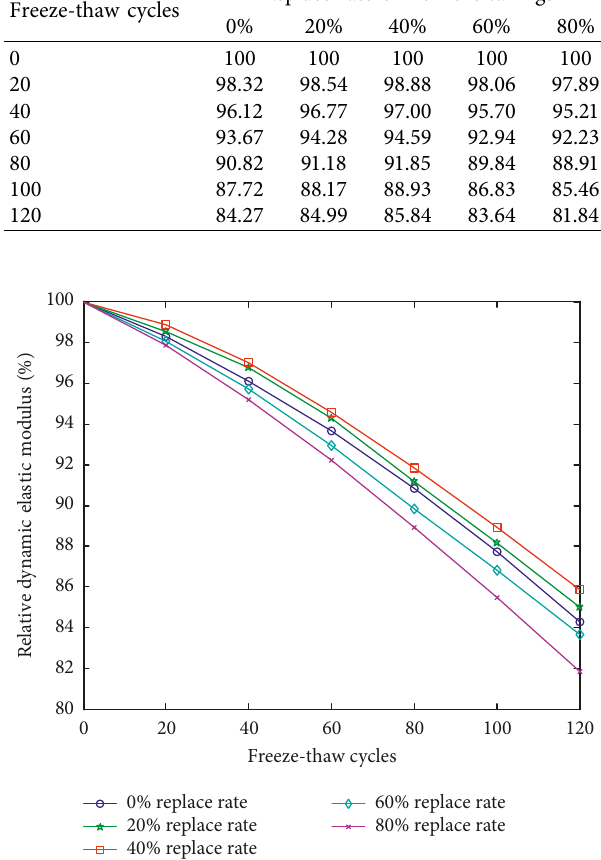
Figure 5: The relationship between the number of freeze-thaw cycles and relative dynamic elastic